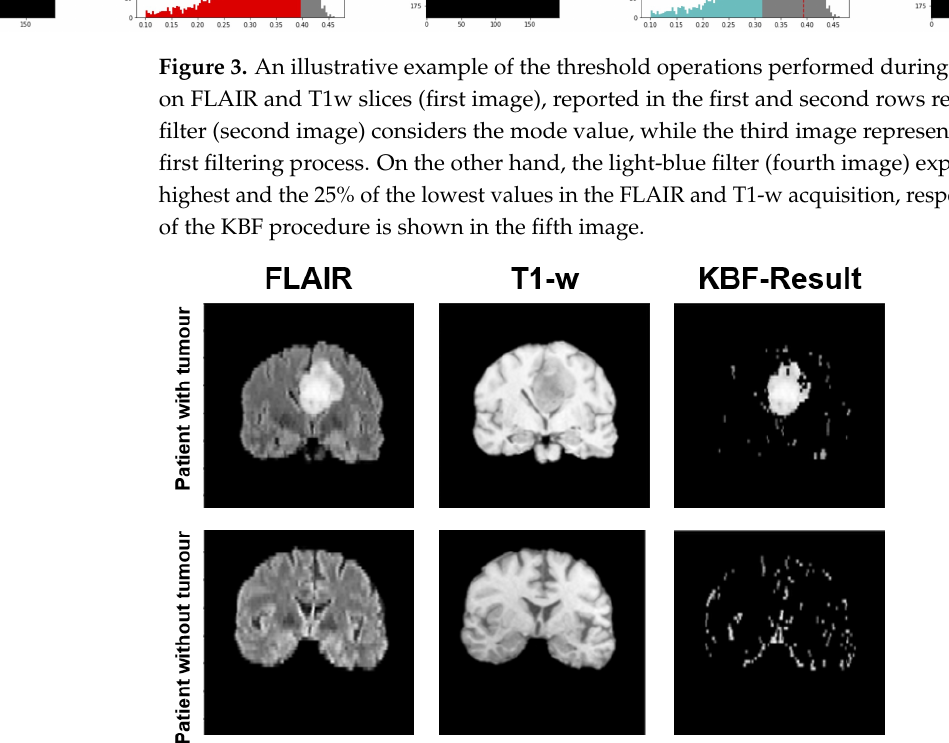
Figure 4. An illustrative example of the results produced by the KBF module on two patients: if the slice contains a tumor ( top row ) a huge cluster is generated in the preselection mask, while in the opposite case ( bottom row ) the mask contains sparse